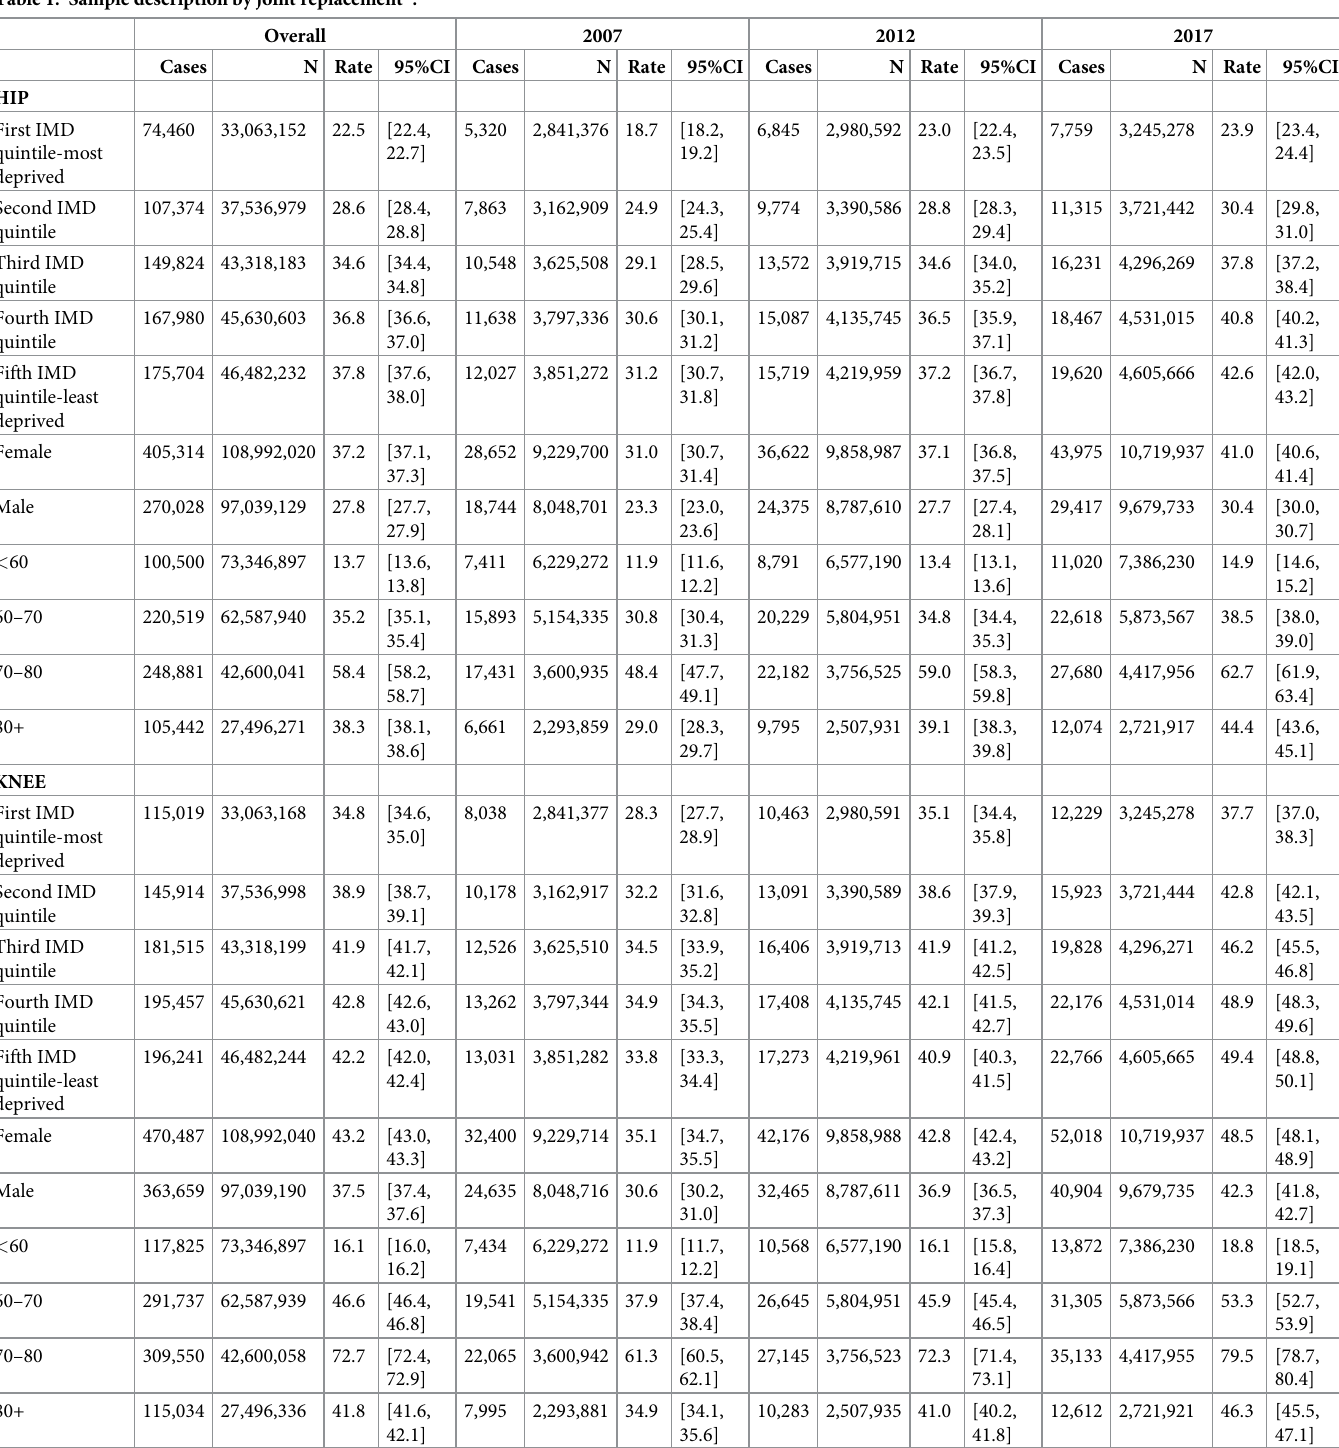
Table 1. Sample description by joint replacement *